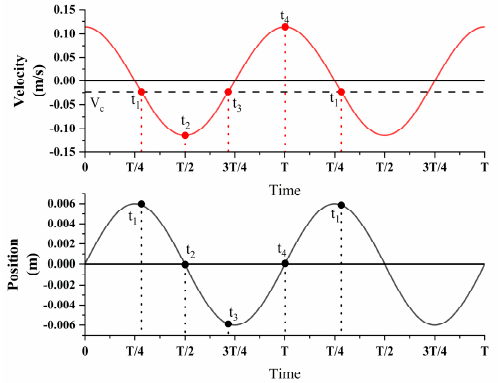
Figure 6. Velocity and displacement of the mold.